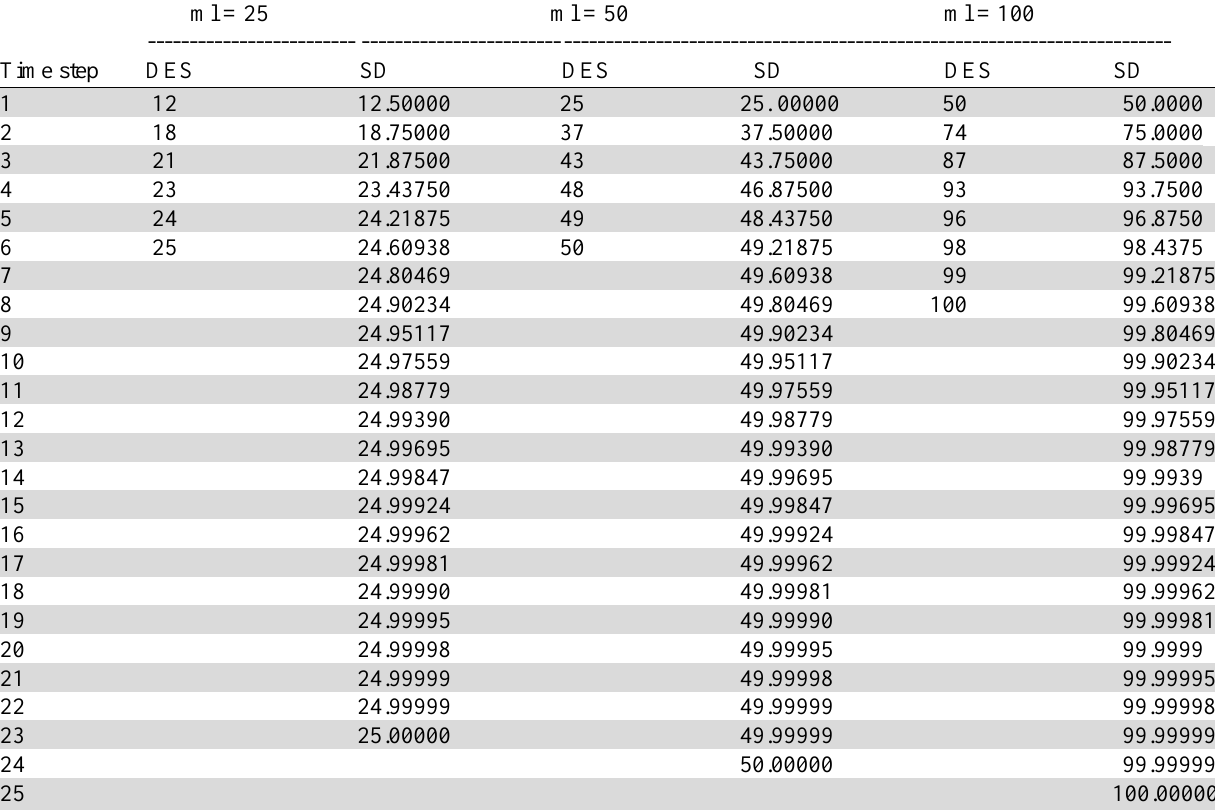
Table 1 The outputs of DES and SD models for different preferred manpower manning level values ml =